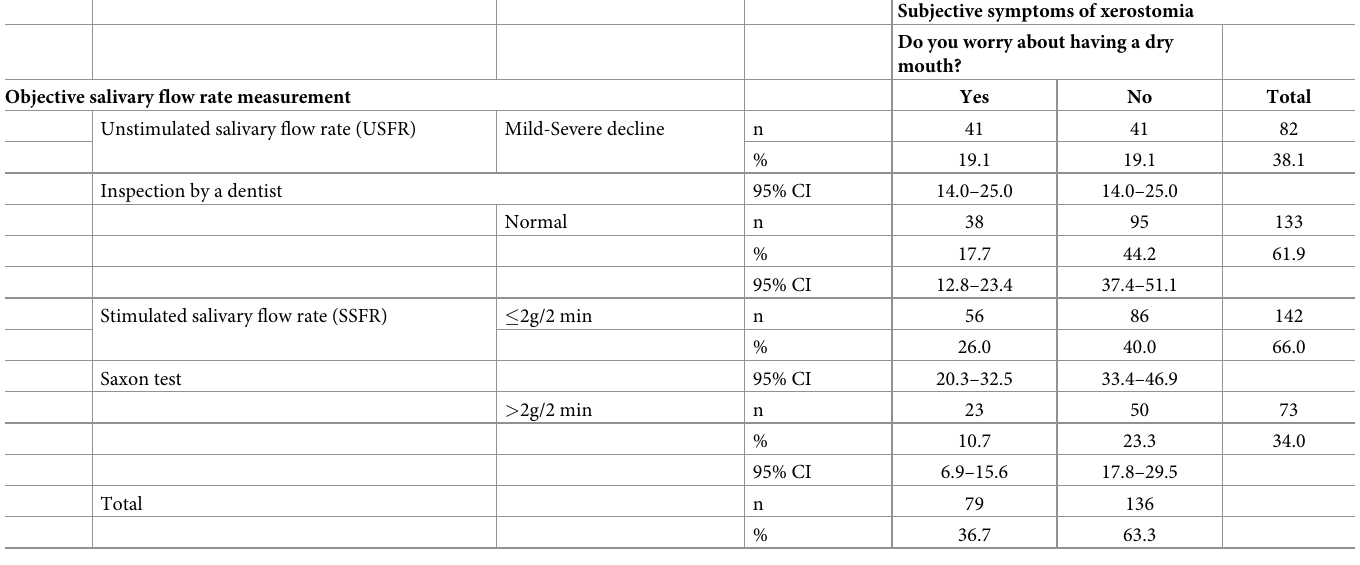
Table 2. Rate of unstimulated and stimulated salivary flow rate by symptoms of